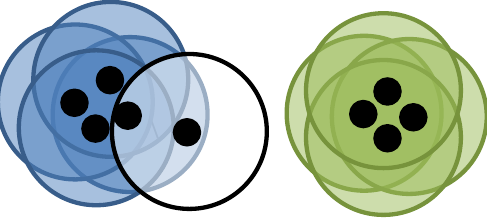
Figure 3. Visual representation of DBSCAN. Here each point is represented as a black dot and its neighbourhood is represented by a circle. Here (cid:15) is the radius of the circle and the minimum number of points is 3. Four points have each been placed into the blue cluster and green cluster, all of which having at least 3 other points in their neighbourhood. One point is classified as noise as it has only 1 other point in its